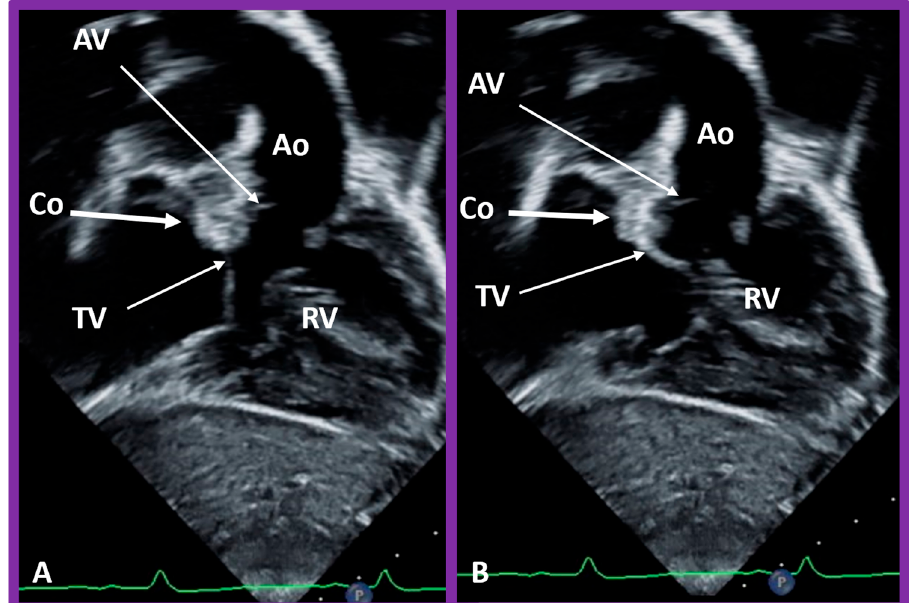
Figure 51. Selected video frames in subcostal views to demonstrate the atrioventricular valve-to-semilunar valve relationship in a child with l-transposition of the great vessels demonstrating a lack of continuity between the aortic valve (AV) and tricuspid valve (TV) leaflets due to conus (Co) separating them. The TV closed in ( A ) and open in ( B ). Ao, aorta; Right ventricle (RV).